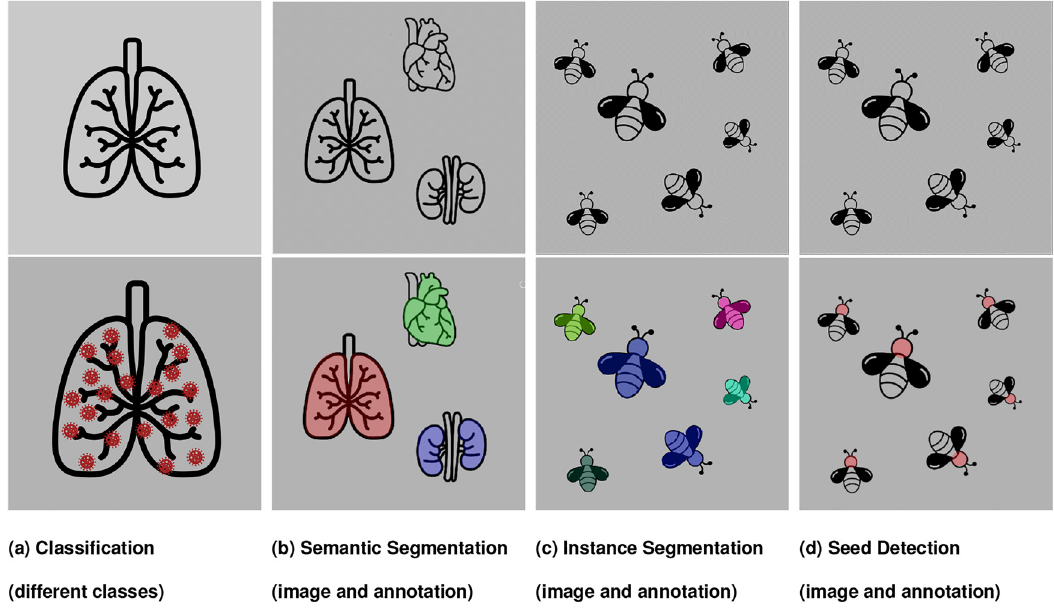
Figure 2: Overview tutorial datasets. Tutorial datasets are provided to facilitate the entry into the use of KaIDA. For instance, the classification (a) of not infected lungs (a, first row)/infected lungs (a, second row), the semantic segmentation (b) of organs (heart, lung, or kidney), and instance segmentation (c)/seed detection (d) of bees. The results of annotation regarding the tasks (b–d) are masks (second row). Whilst each color of the semantic mask represents a different class (b, second row), the colors of the mask resulting from instance segmentation represent a different instance of the same class (c, second row). In the case of seed detection, the intention is only to count instances and not to completely segment them. Hence, only the head of each bee is annotated (d, second